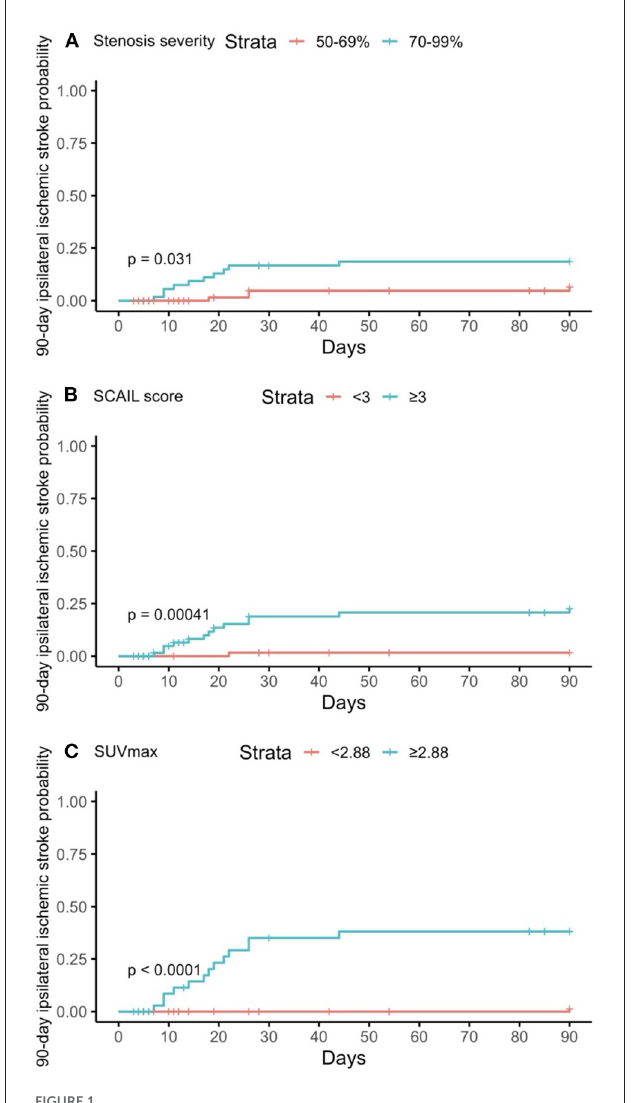
FIGURE1 Kaplan–Meier curves of predictors for 90-day ipsilateral ischemic stroke. (A) Degree of stenosis in symptomatic plaque; (B) Symptomatic plaque SCAIL score; (C) Symptomatic plaque SUVmax. SCAIL, symptomatic carotid atheroma inflammation lumen-stenosis; SUVmax, maximum standardized uptake value.